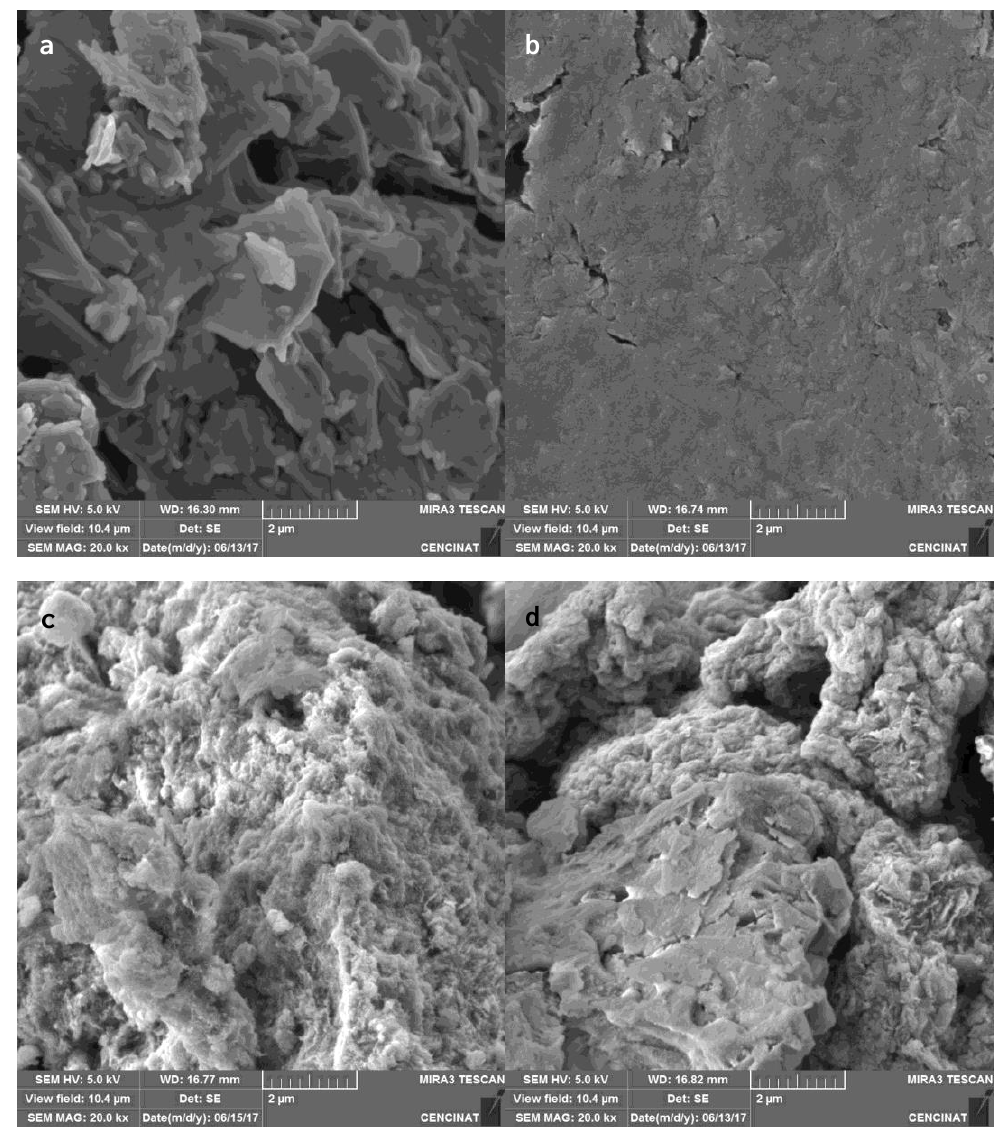
/ rGO 1, and ( d ) α -FeOOH / rGO